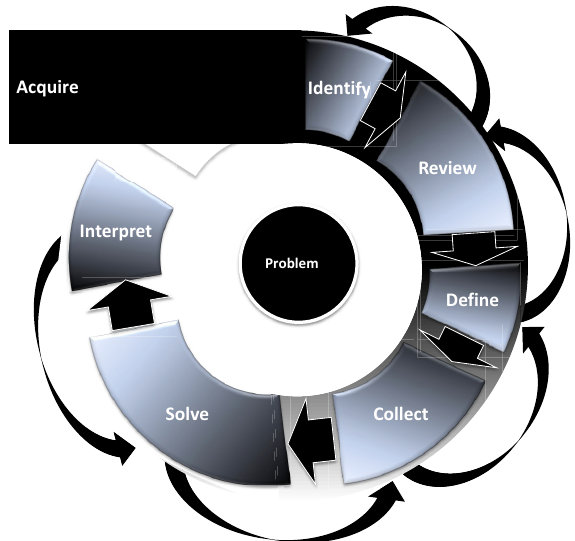
Figure 2. Learning as an Iterative Process Centered Around a Research Identify